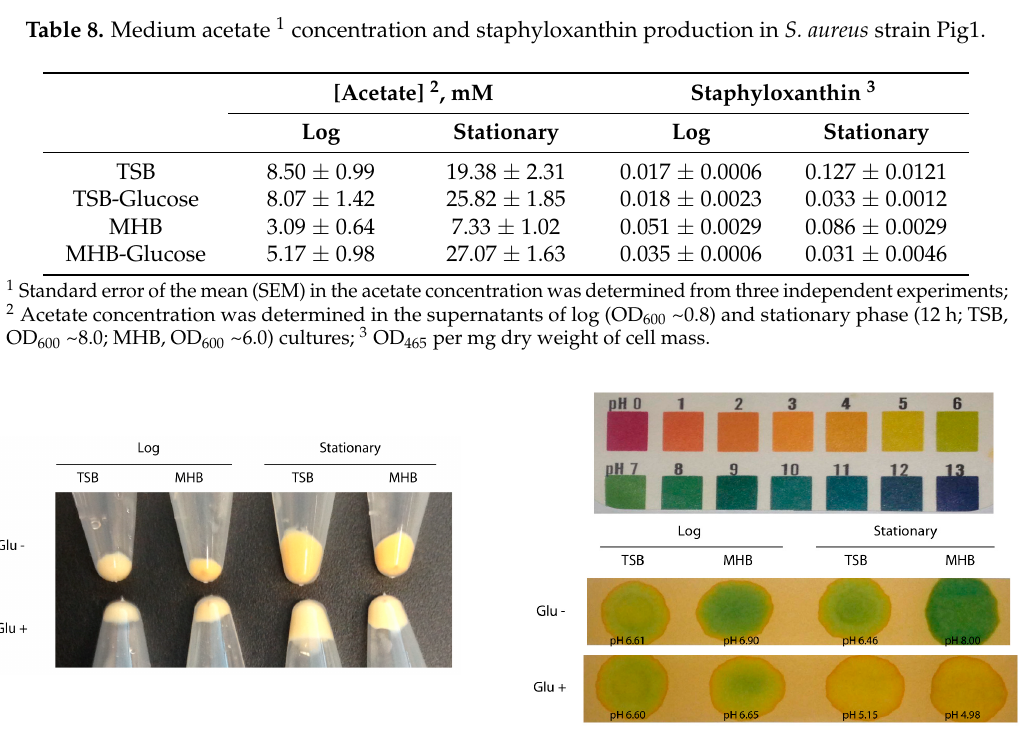
Figure 6. Effect of glucose in S. aureus Pig1 grown in TSB and MHB. ( a ) Pigmentation in cell pellets of strain Pig1 grown with or without glucose in the growth media. The strain was grown in plain TSB or MHB and glucose-added TSB or MHB at log phase (OD 600 ~0.8) and at stationary (12 h; TSB, OD 600 ~8.0; MHB, OD 600 ~6.0). Cell pellets from 5 mL cultures were collected, washed, and photographed; ( b ) pH change in the culture supernatants. pH change in the corresponding culture supernatants was NY). Five microliter of each supernatant was put on the pH paper. Upper panel shows the reference color for a given pH value.